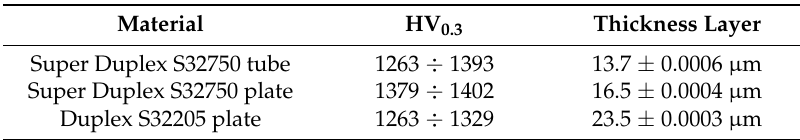
Table 2. Sample identification, HV 0.3 hardness (maximum and minimum range values), and medium thickness of the nitride